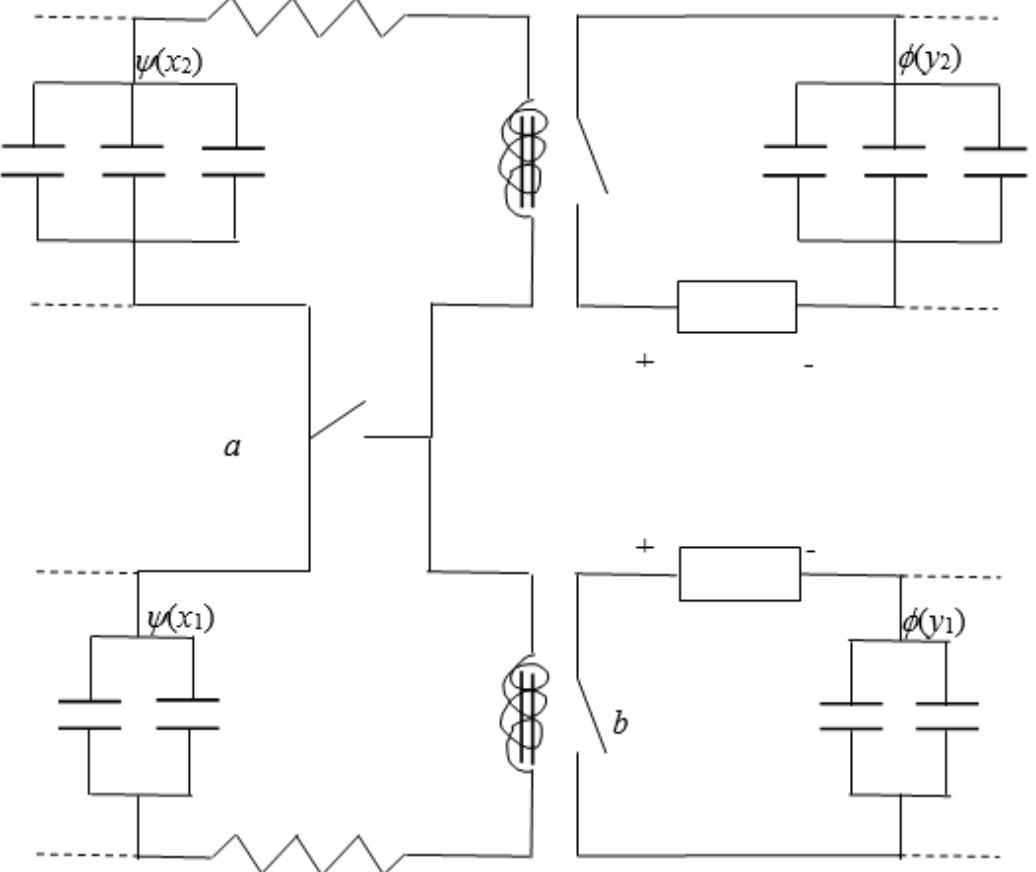
Figure 1. Electrical diagram of the quantum jump ψ → φ (for simplicity, only two pairs of opposing meshes are represented).